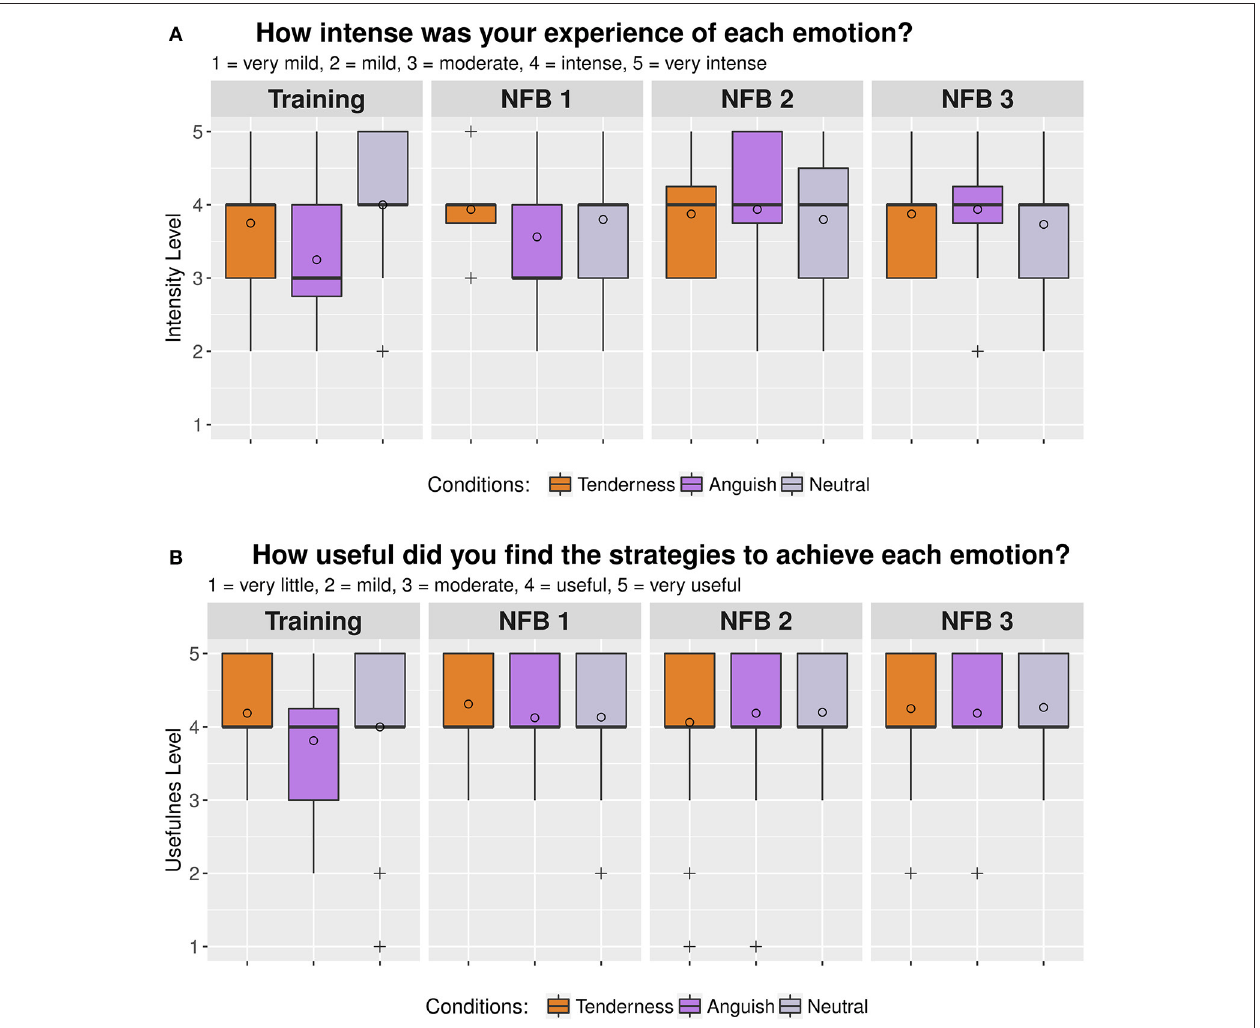
FIGURE 4 | Box plot of self-reported rating measured in eight participants over two consecutive assessment days immediately after each of the four MRI runs. (A) self-reported intensity of emotions during neurofeedback and (B) self-reported usefulness of strategies to up regulate emotions. The circles represent the mean values and the crosses represent